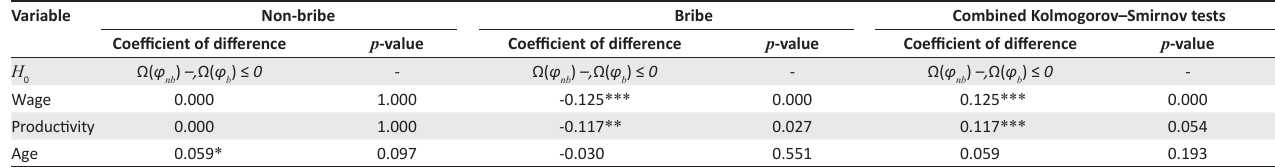
TABLE 3: Kolmogorov–Smirnov tests of stochastic